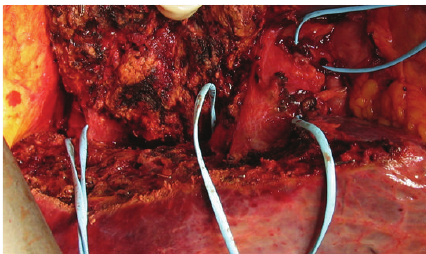
Figure 4: The liver in a patient with large colorectal liver metastases on the right side at the end of stage 1 operation. Ligaloops are placed around the right hepatic vein, the right portal triad, and the right hepatic